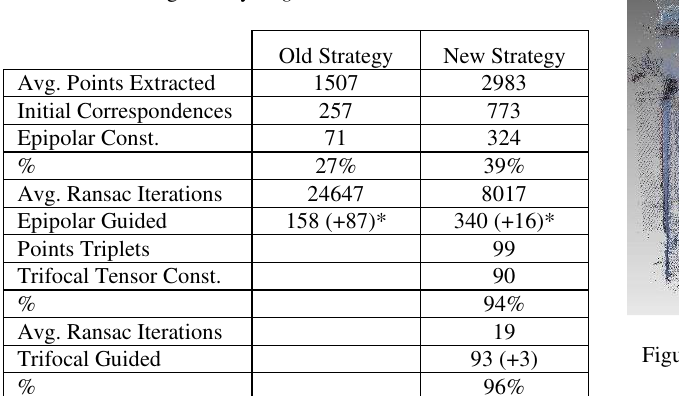
Figure 6. The Canopic Jar Lid sequence. Left : the image block geometry. Right : the DSM.